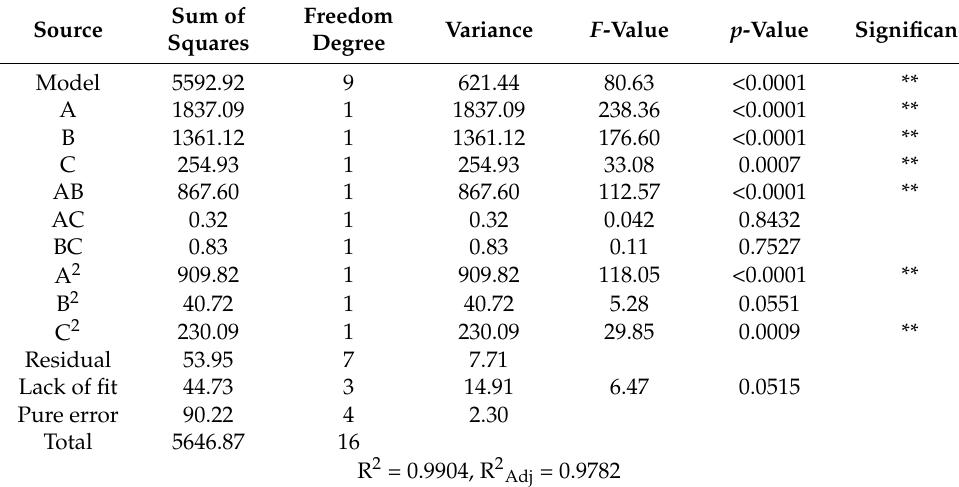
Table 2. Analysis of variance (ANOVA) of the regression equation.